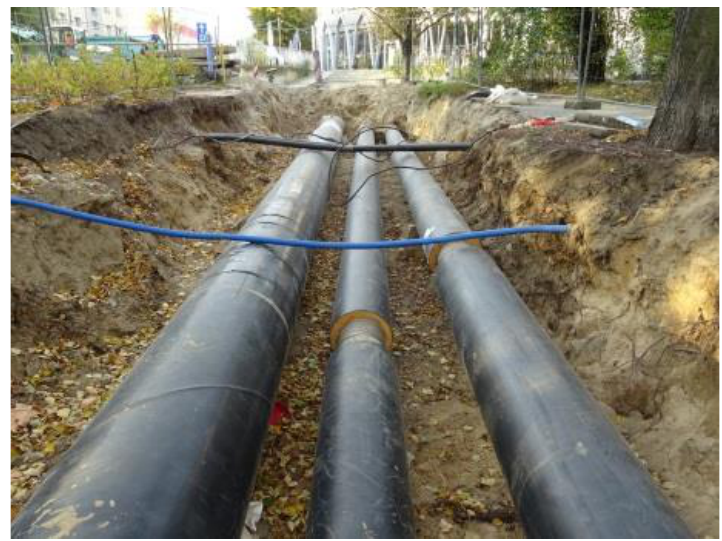
Figure 1. Example of pre-insulated heating pipes located in the ground layer at a depth of up to 1 m. There are many models of temperature distribution in the ground in the